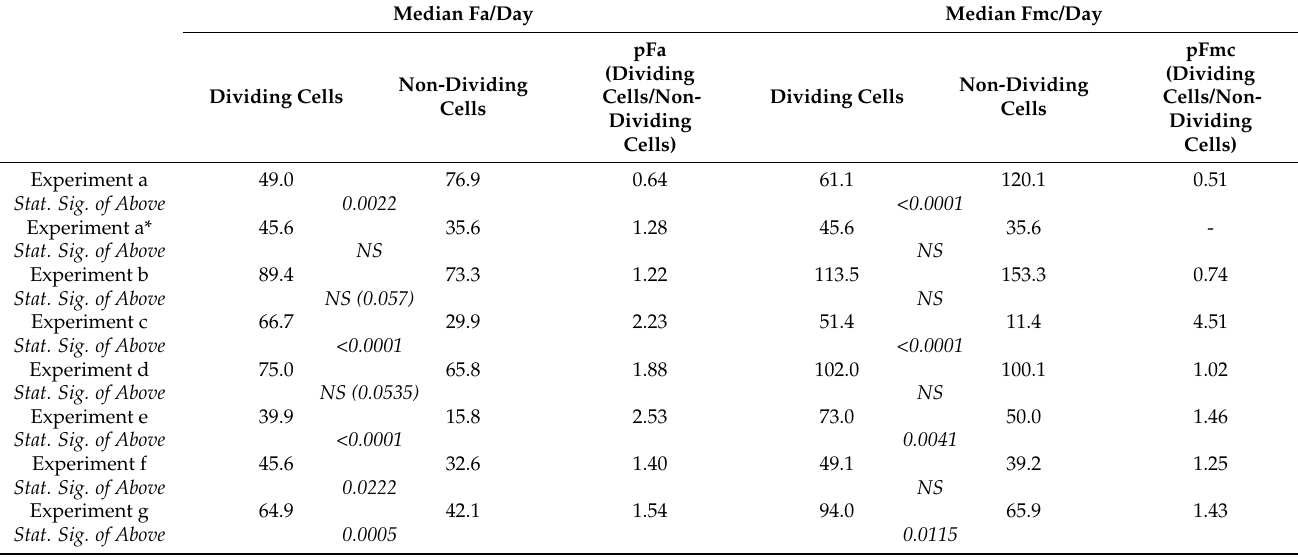
Table 4. The fate of SAOS-2 cells with regard to cell division, related to the rate of previous fluorescence uptake from co-cultured HDFs. Median rates of acquisition of fluorescence are given for absolute fluorescence acquired per day (Fa/day) and fluorescence compensating for halving on division of immediate mother cells (Fmc/day). Statistical significance (Stat. Sig.) as per the Mann–Whitney U test is given, where NS indicates ‘not significant’ at p < 0.05. Where statistical significance was approached but not reached, the calculated p -value is shown ( NS (p-value) ). All generations of cells for which adequate data were available were included in the analyses. However, in experiment ‘a’, first-generation cells had atypical results compared with all other experiments, with disproportionate effect on pooled results. For this reason, two results for experiment ‘a’ are shown, one including these cells and another where only cells in the starting generation of experiment ‘a’ were analysed (Experiment a*). To assess persistence of effect, both pFa and pFmc are shown for all experiments other than for experiment ‘a*’, where pFmc has no